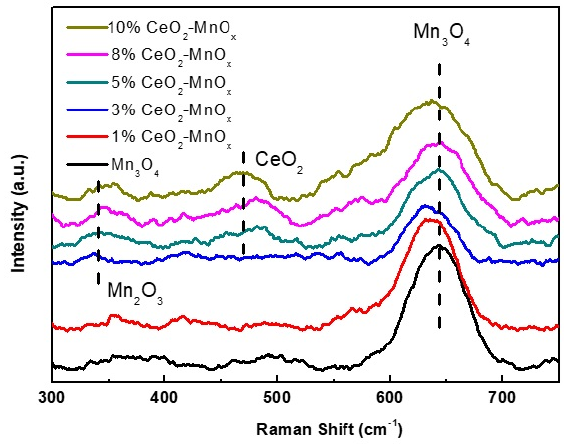
Figure 6. Visible Raman of w CeO 2 –MnO X .